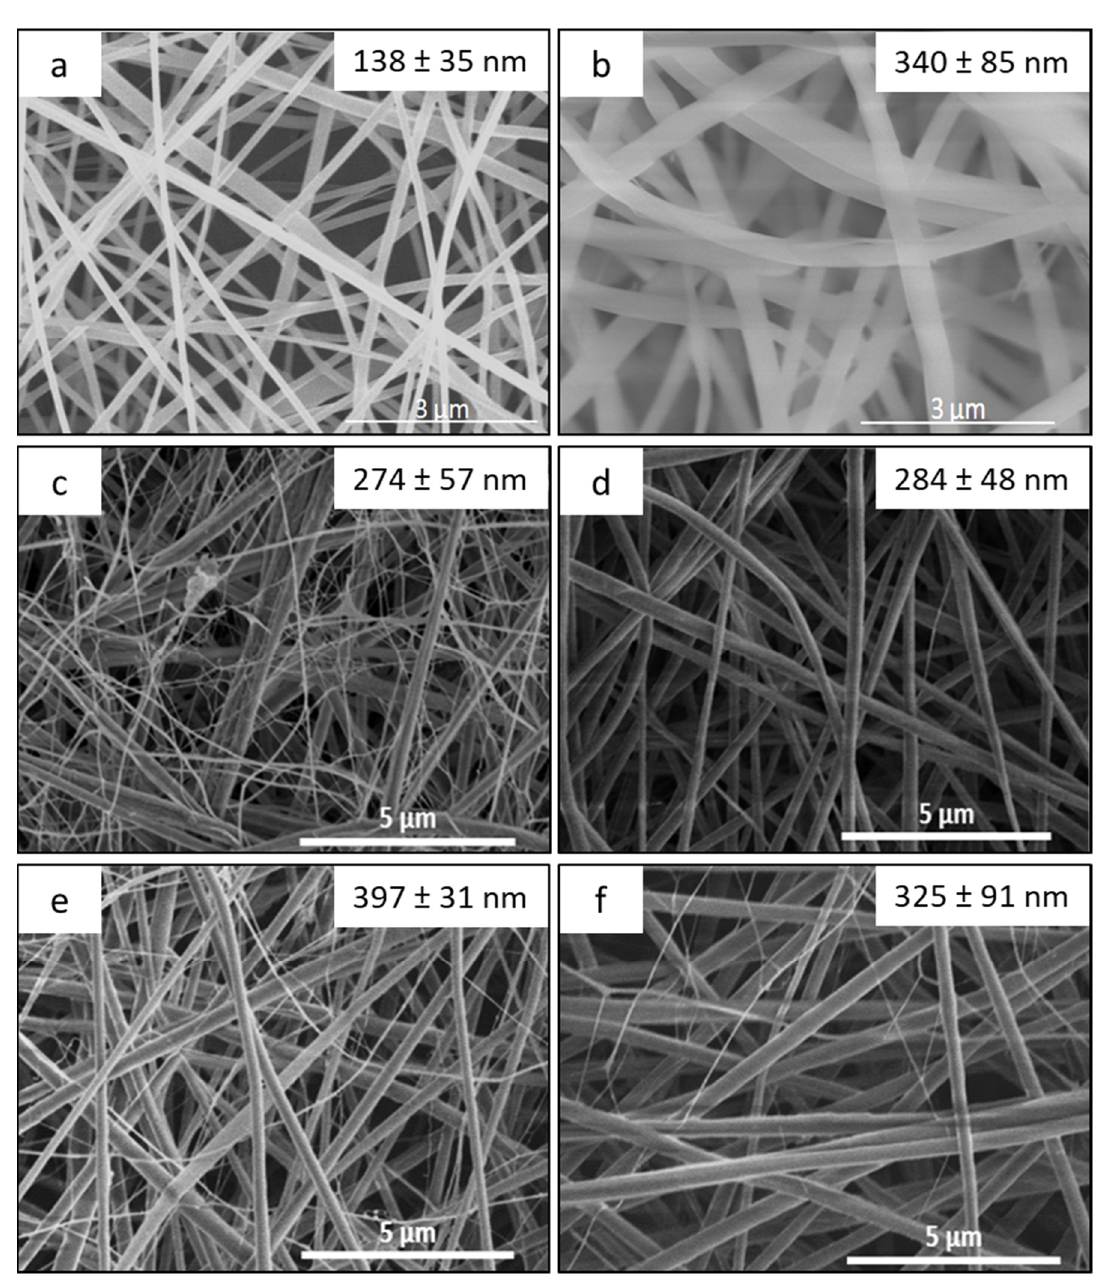
Figure 2. SEM pictures of monolithic ( a ) M0, ( b ) M1 and core-sheath ( c ) CS1, ( d ) CS2, ( e ) CS3, ( f ) CS4 nanofibers. ( f ) CS4